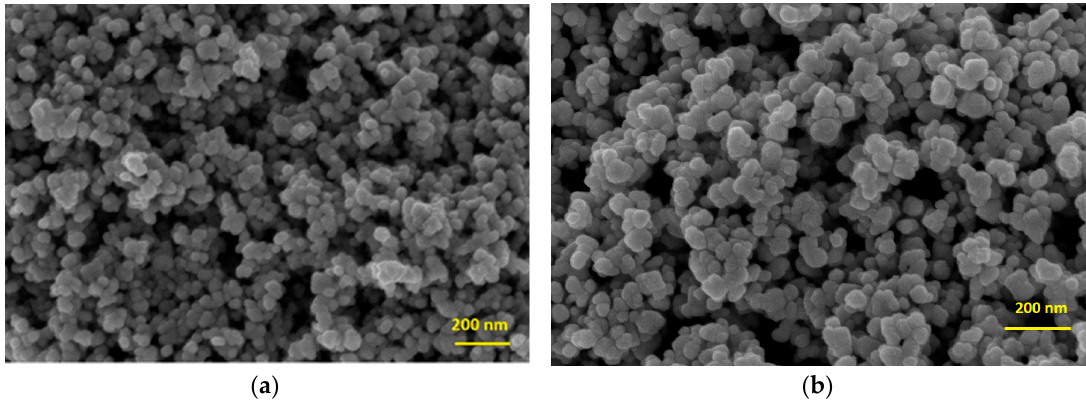
Figure 1. FE-SEM micrographs of sensors: In 2 O 3 ( a ); W-In 2 O 3 ( b ).